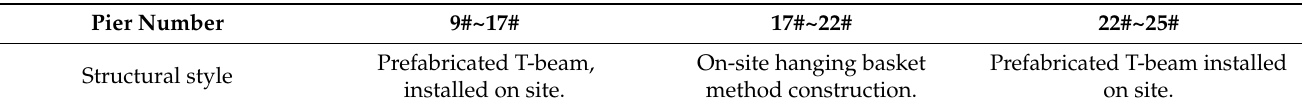
Table 6. Summary of project management data.